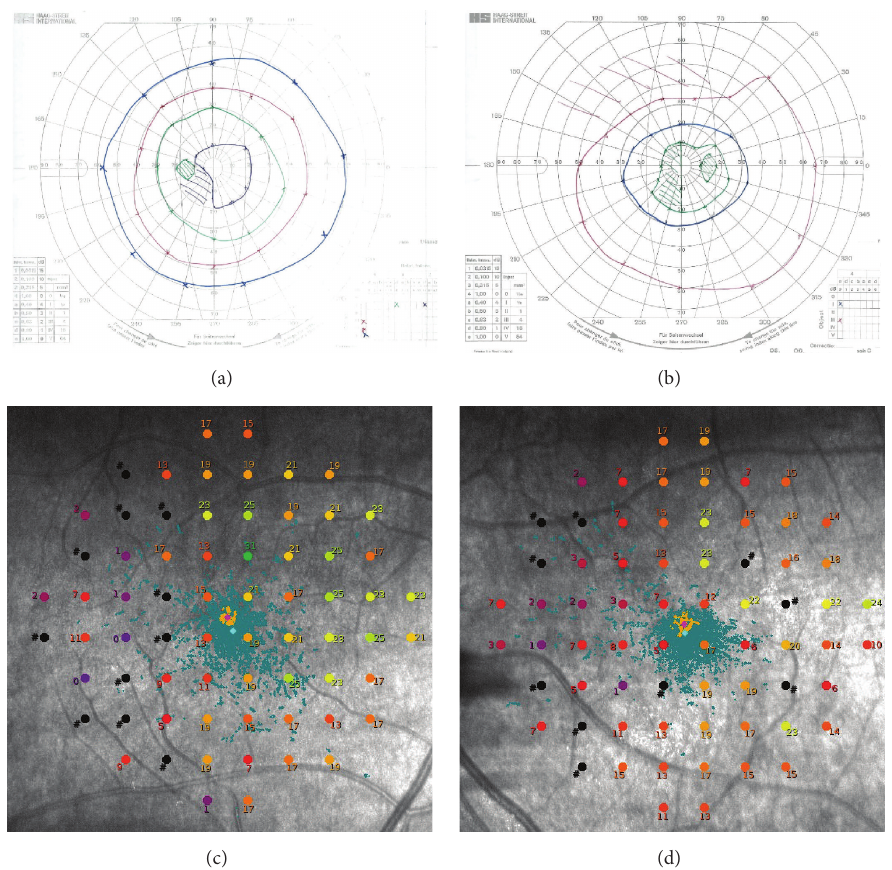
Figure4:(a,b)LeftandrightGoldmannvisualfieldsshowingcentralincongruoushomonymoushemianopiaobeyingtheverticalmidline.(c, d) Right and left MAIA microperimetry demonstrated diffuse reduced retinal sensitivity (abnormal sensitivity is < 25 dB) with nasal-temporal asymmetry.